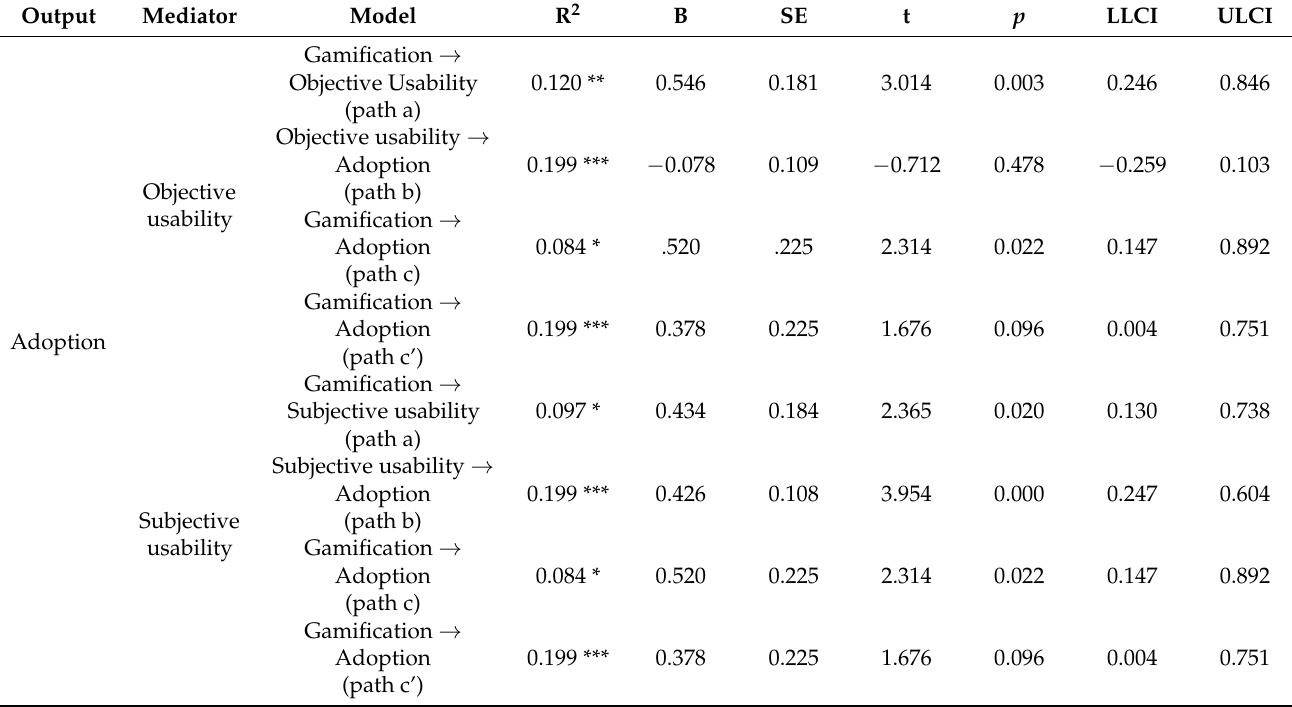
Table 8. Direct effects of gamification on adoption via objective and subjective usability of in-person